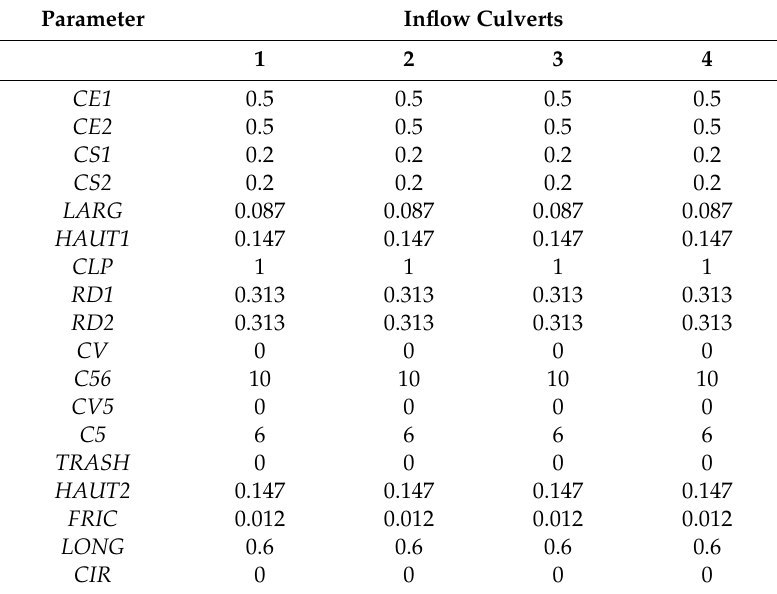
Table A2. Culvert parameter values for the scale model without a trash